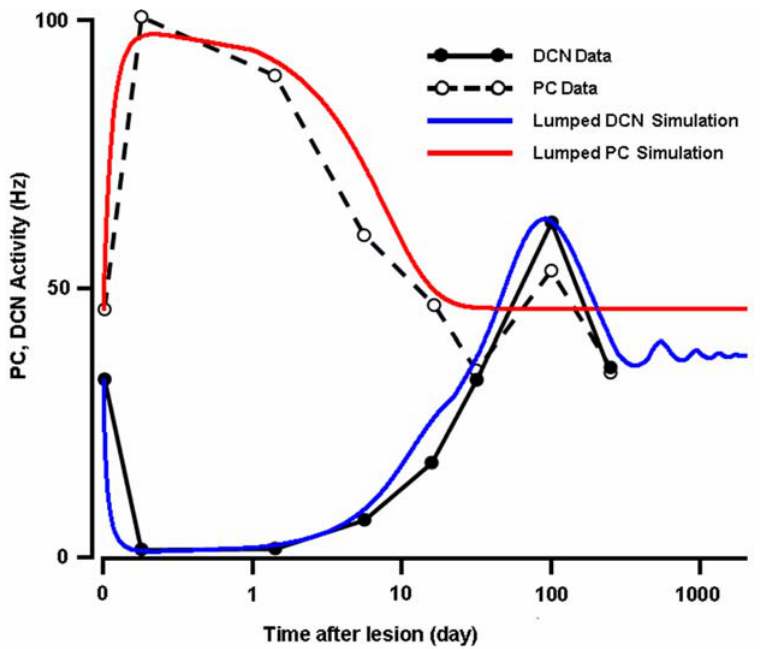
Figure 10. Simulation of post-IO lesion activities of PC and DCN. The experimental data of DCN (filled dots and black line segments) and PC (blank dots and dashed line segments) firing rates are from Batini et al. (1985). The model predicts beyond experimental data points (250th day) that, (1) the PC (in red) recover their baseline firing activity to the pre-lesion level and, (2) the DCN activity (in blue) stabilizes at an elevated level. These two predictions are consistent with the observation by Billard and Daniel [47]. See the Supporting Information Note 3 in Text S1 for detailed mechanisms of the network behavior.